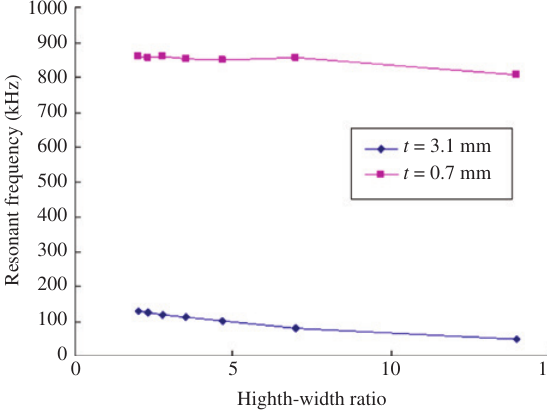
Figure 12: Relationship between aspect ratio and